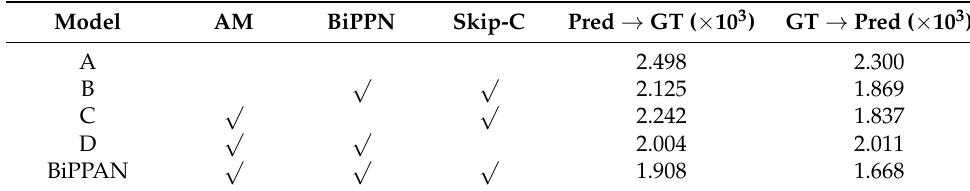
Table 4. Ablation study on different components of our proposed encoder–decoder network frame- work, including Attention Module (AM), Bidirectional Point Pyramid Network (BiPPN), and skip connections (Skip-C).